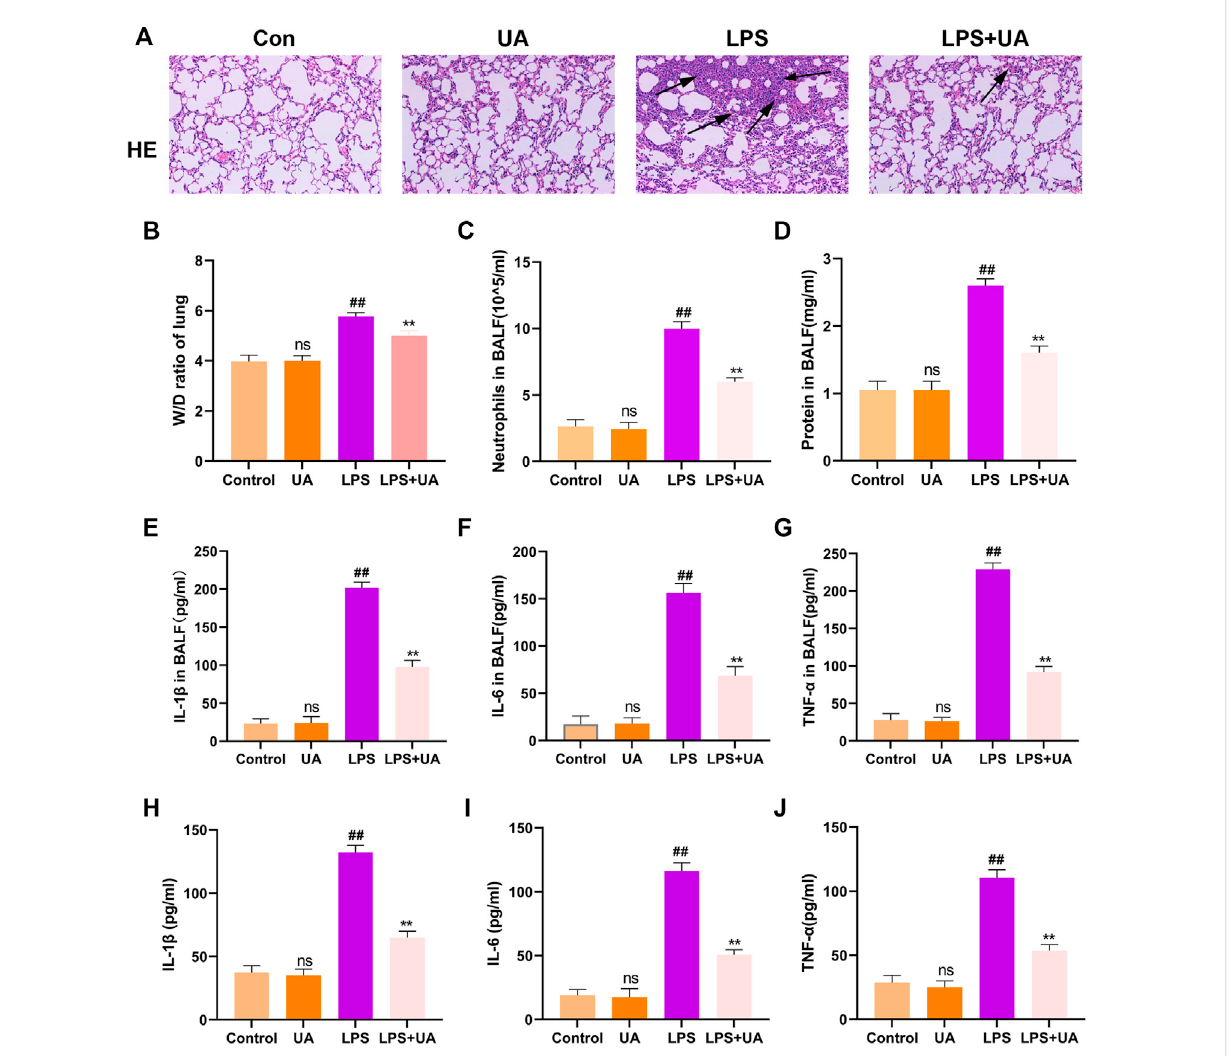
FIGURE 2 Role of Urolithin A (UA) in LPS-mediated ALI in BEAS-2B cells and mice. (A) H&E staining images of Lung tissue. (B) Lung W/D weight ratio. (C,D) Neutrophilnumberand proteincontent oftheBALF. (E – G) TNF- α , IL-1 β ,and IL-6expressionsinmouse BALFweremeasured byELISAassay. (H – J) TNF- α ,IL-1 β ,andIL-6expressioninBEAS-2BcellsculturesupernatanttreatedwithLPS(10 ug/mL)wereanalyzedthroughELISAassay.Theresultswereshown as mean ± SD. ## p < 0.01, ** p < 0.01 in comparison to control and LPS groups,